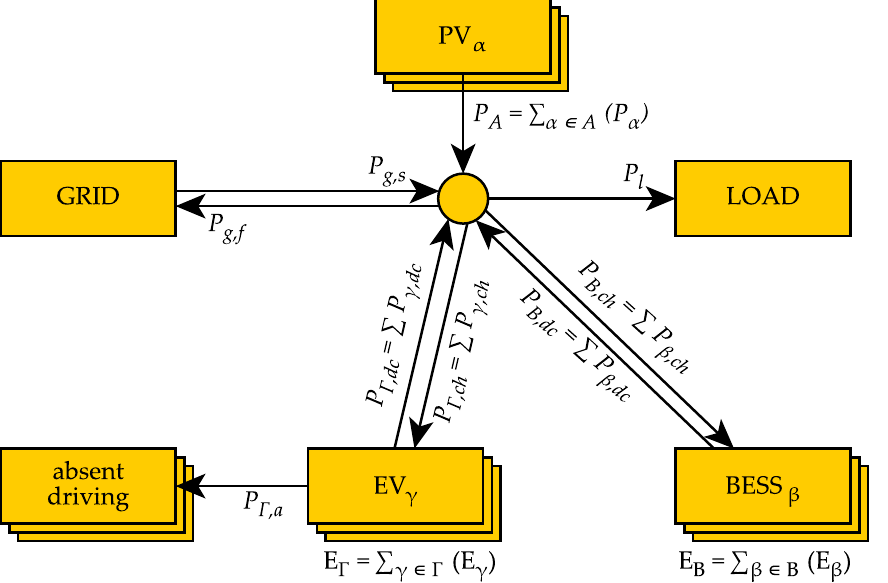
Figure 1. Block diagram of the controller system model containing multiple devices. The device types PV, EV, and BESS are modelled individually and occur in sets A , B , and Γ . The grid connection (GRID) and the aggregated power demand (LOAD) are each modelled as a single